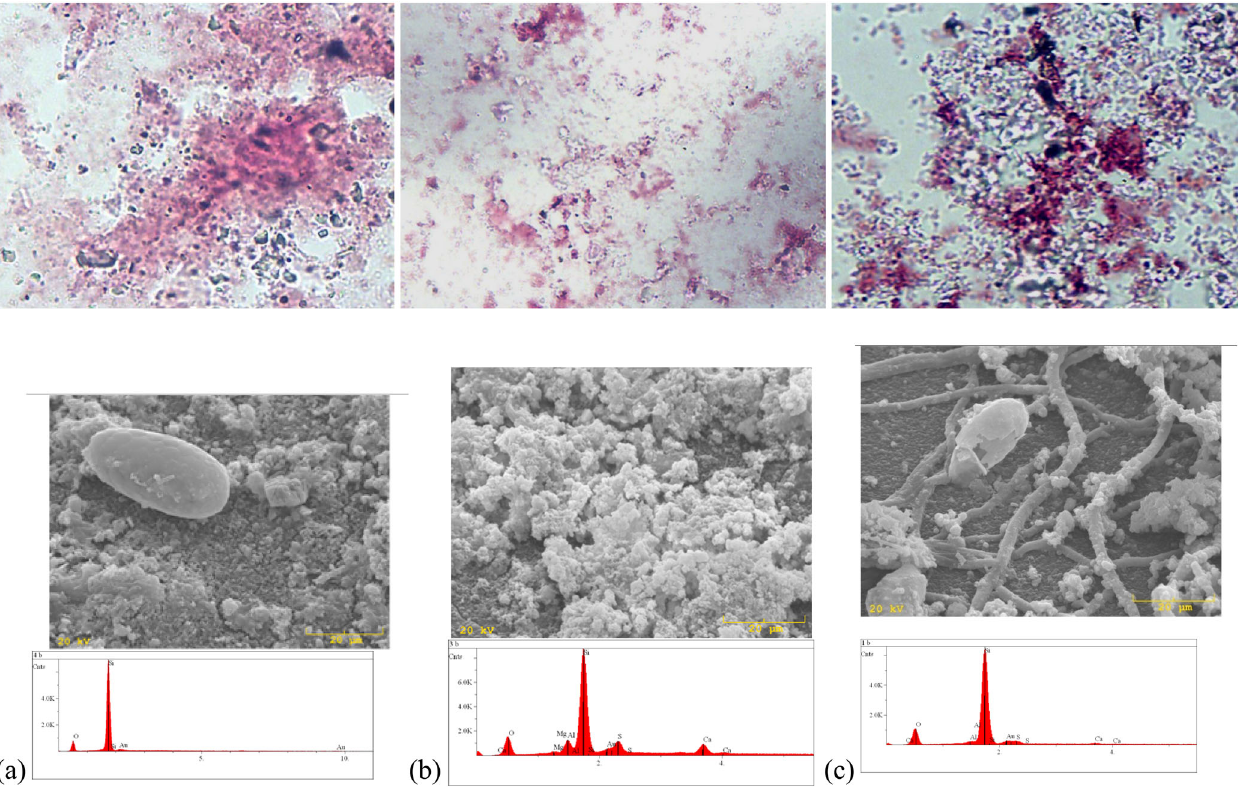
Fig. 3 Optical and scanning electron microscope images and energy-dispersive analysis of X-rays for membranes at a brackish groundwater RO plant. Previously unpublished light microscopy with Gram staining (top), SEM images (middle) and EDX (bottom) spectra from ( a ) fi rst stage, lead element, ( b ) second stage, tail element and ( c ) third stage, tail element of the City of Santa Monica ’ s Arcadia brackish groundwater desalination plant (Santa Monica, California, USA).